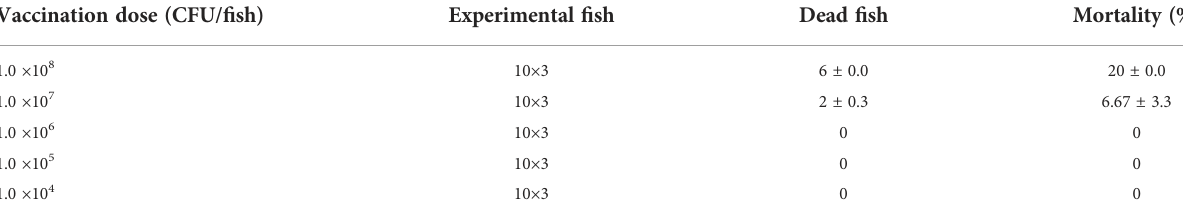
TABLE 2 Safety evaluation of live attenuated vaccine D dctP